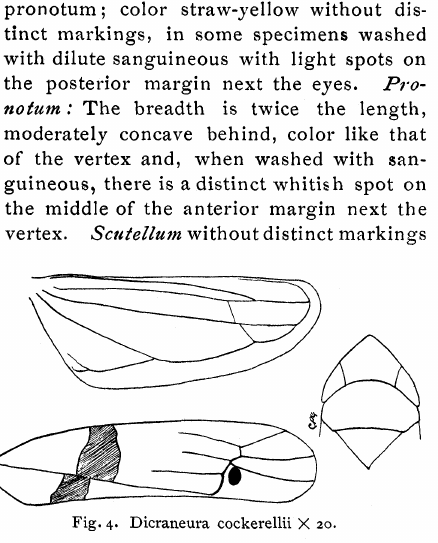
Fig. 4. Dicraneura